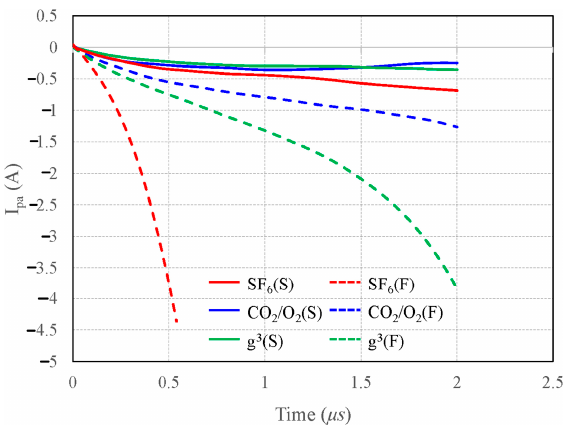
Figure 8. Comparison of post-arc current (I pa ) according to SF 6 , CO 2 /O 2 , and g 3 gases (post-arc current behaviors within 2 µ